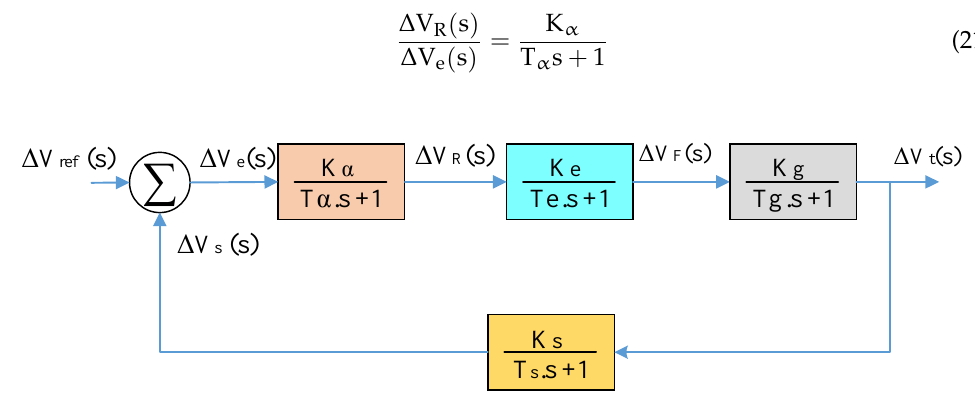
Figure 5. AVR system block diagram.